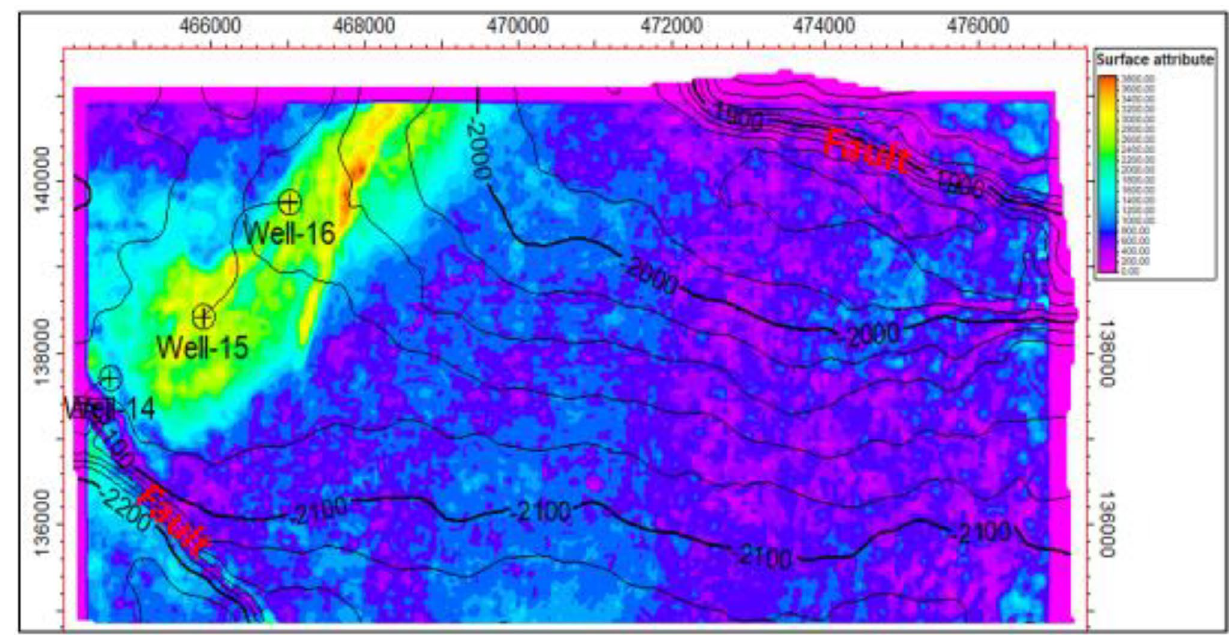
Fig. 9 Extracted sweetness attribute map along H4